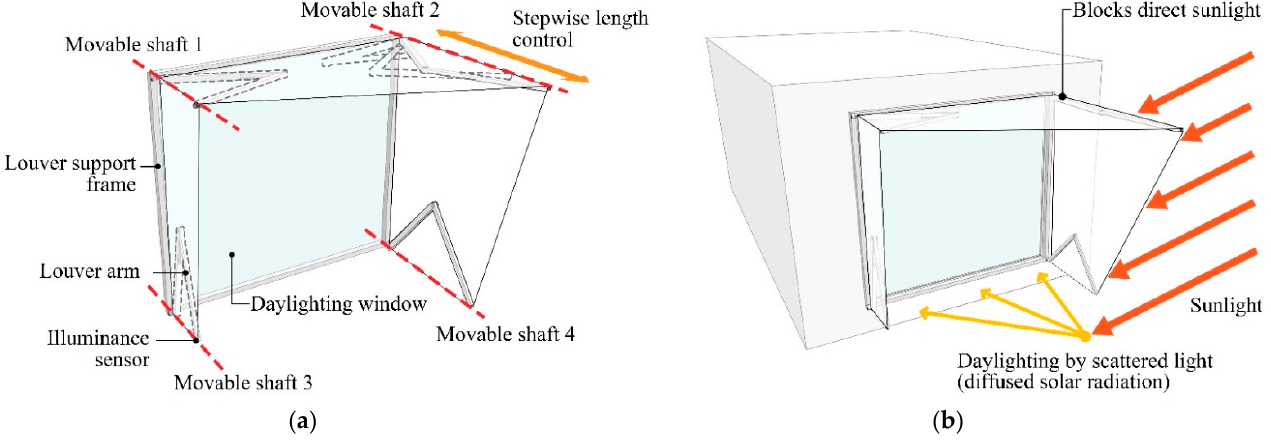
Figure 3. Structure and operation of solar tracking-based movable louver (STML) system. ( a ) Struc- ture and operation principle. ( b ) Concept of daylighting and shading.